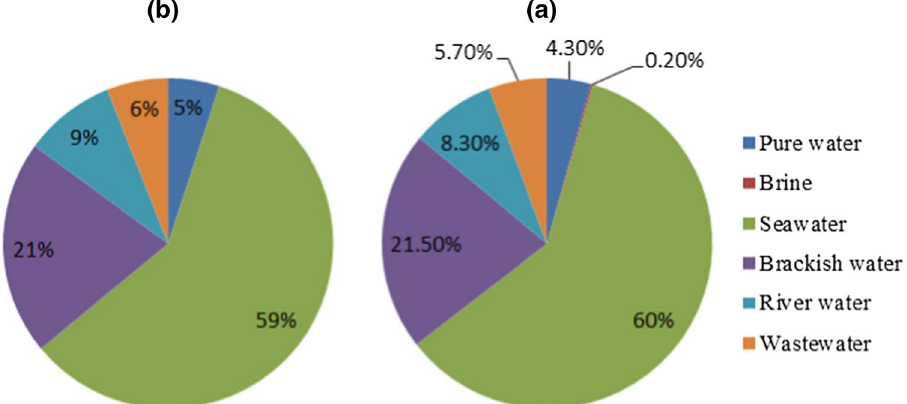
Fig. 5 Shares of water resources for the desalination process for 2010 ( a ) and 2011 ( b ) (Abrams